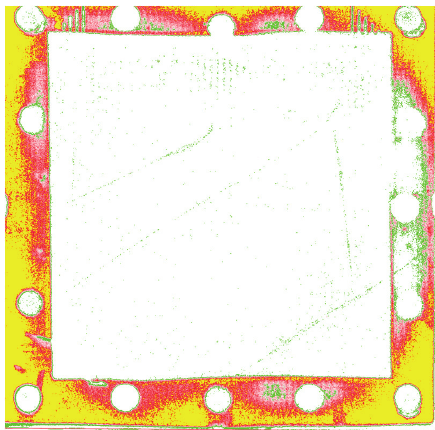
Figure 4: Pressure distribution between BPP and GDL under 5 Nm torque for 0.4 mm gasket